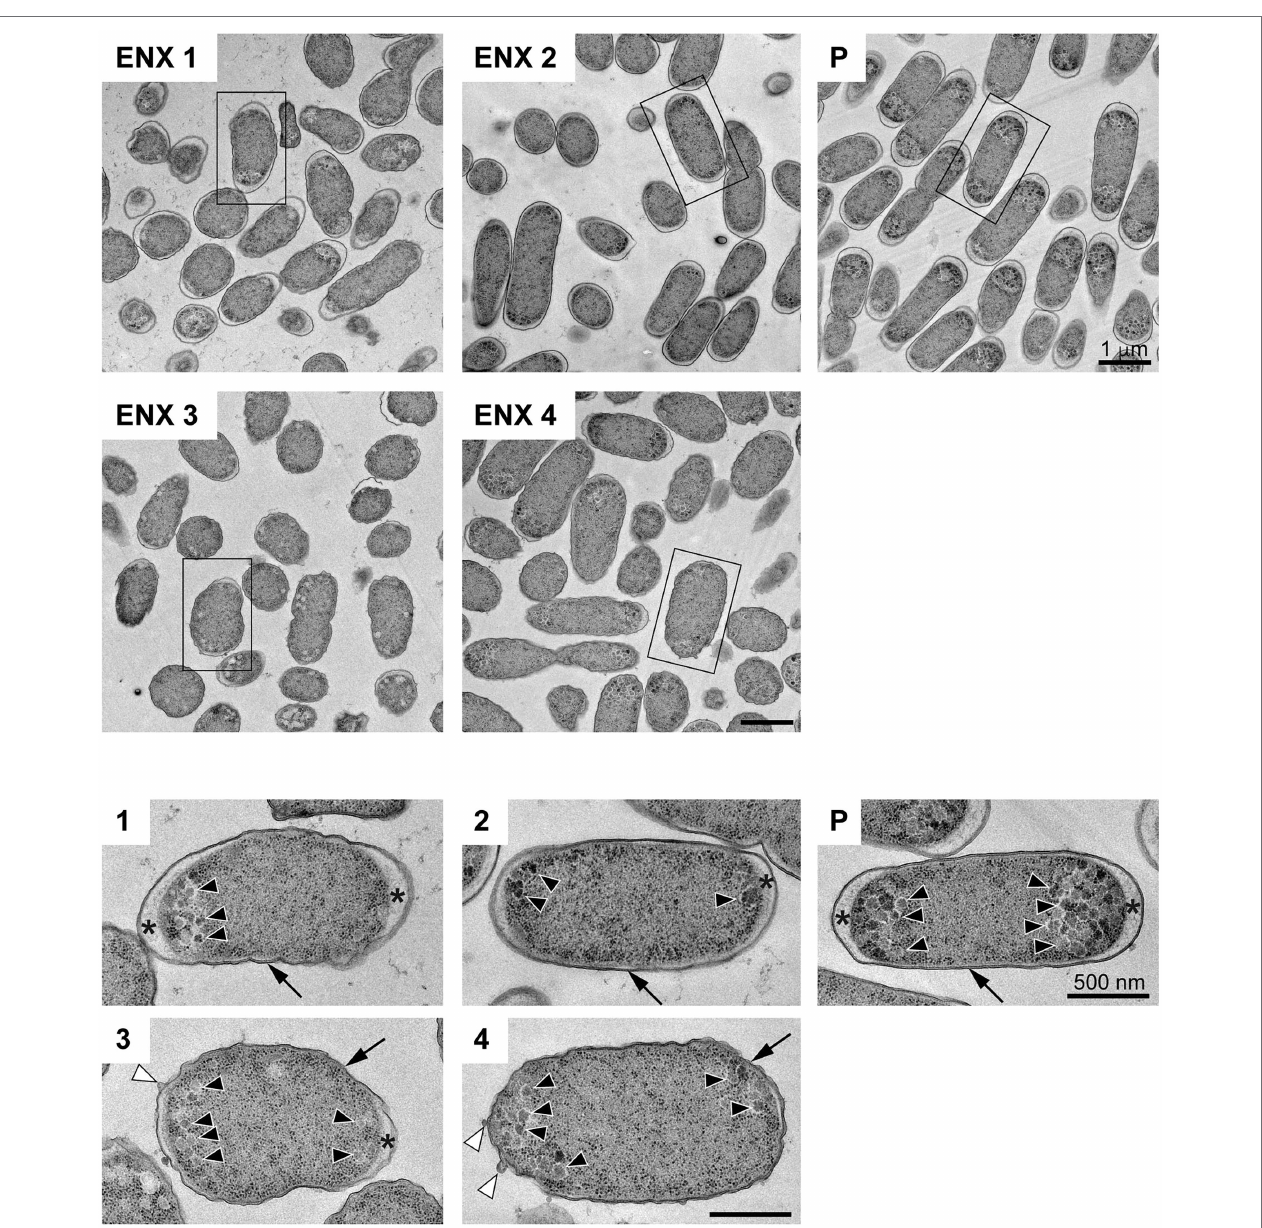
FIGURE 2 | Ultrastructure of the ENX-resistant cells. Upper panels show representative transmission electron micrographs of the ENX-resistant cells and the parental (P) cells. Lower panels show magnification of the boxed bacterial cells in upper panels, depicting the detailed morphology of the cells. The number denotes the indicated ENX-resistant strains. The outer membrane, granules, bleb-like structures, and periplasmic space are indicated by an arrow, arrowheads, white arrowheads, and asterisks, respectively. Scale bars, 1 μ m in upper panels; 500 nm in lower